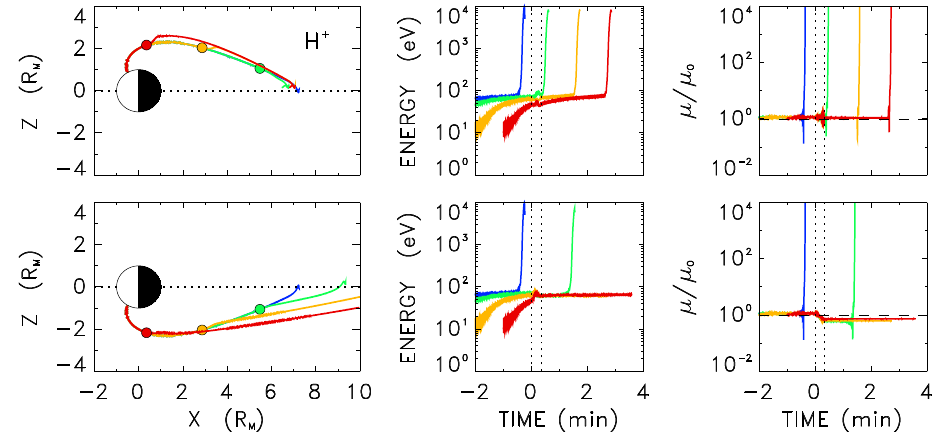
Fig. 10. Identical to Fig. 8 but for